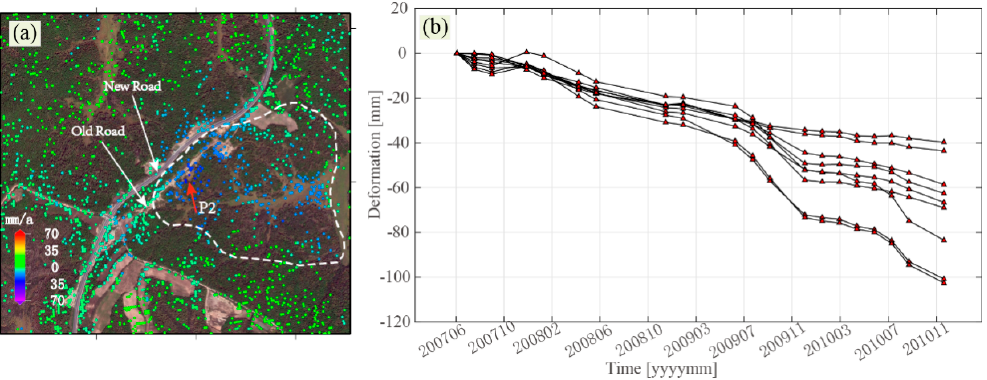
Figure 12. ( a ) deformation of the selected area P2. The white dashed polygon denotes the island permafrost. ( b ) the deformation time-series in the region indicated by the red arrow.